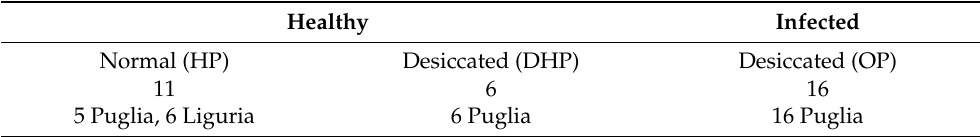
Table 2. Distribution of samples, state, and